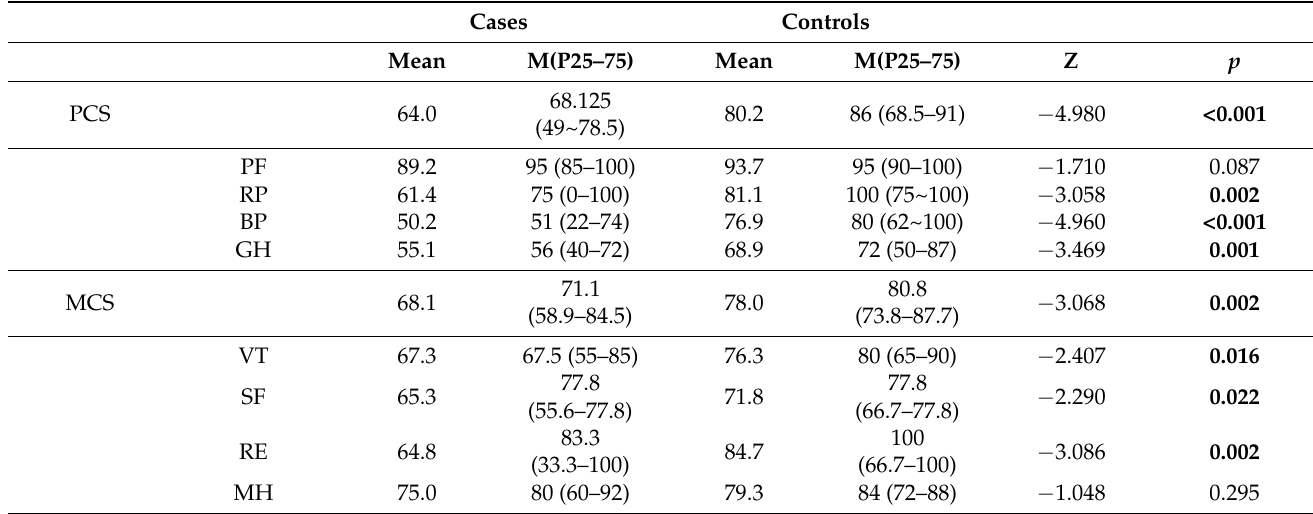
Table 4. SF-36 in patients with and without adenomyosis.